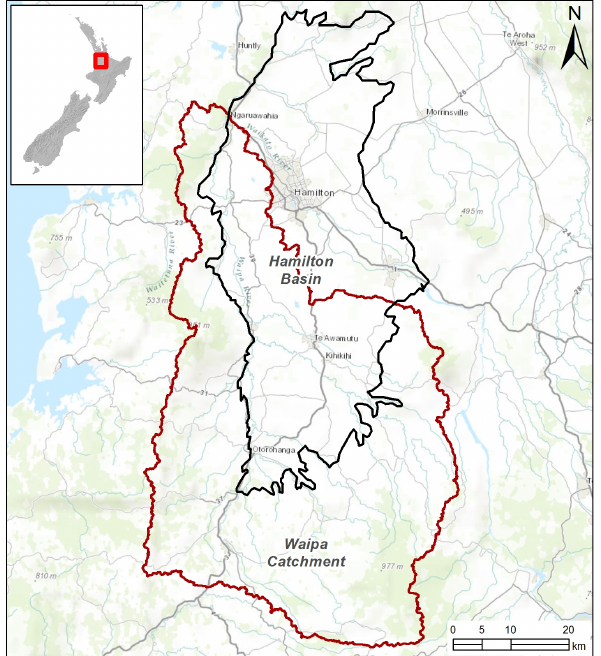
Figure 11. Waipa River catchment, Waikato region, New Zealand. The study area is shown in red. The low-lying Hamilton Basin is shown in black (Rawlinson, 2014, their Fig. 1.2).